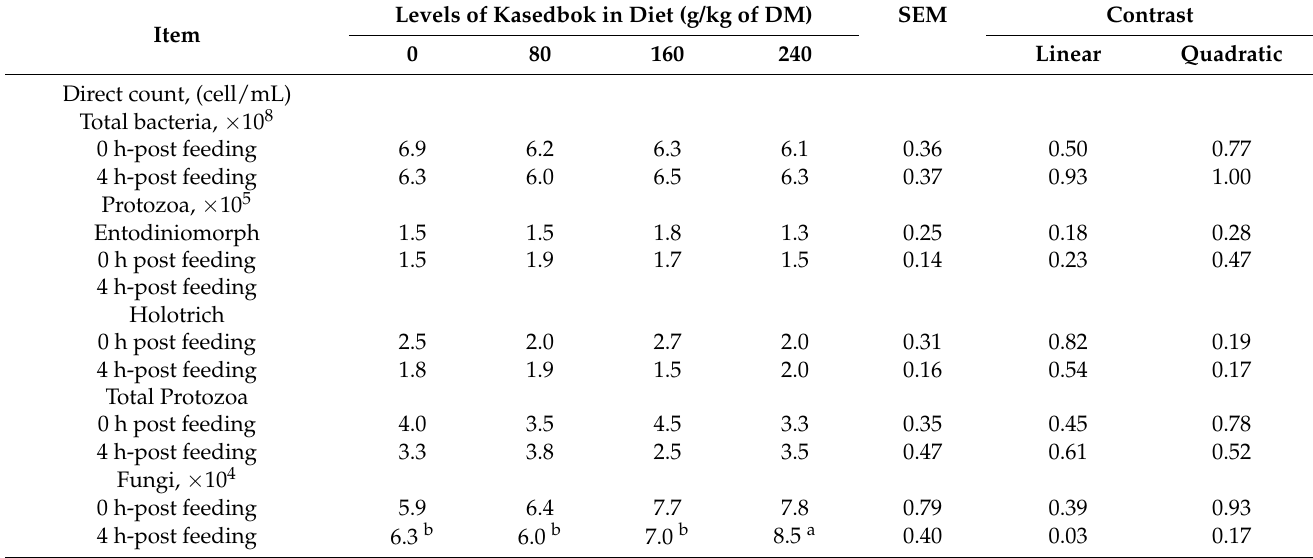
Table 5. Microbial population in the rumen of Thai native beef